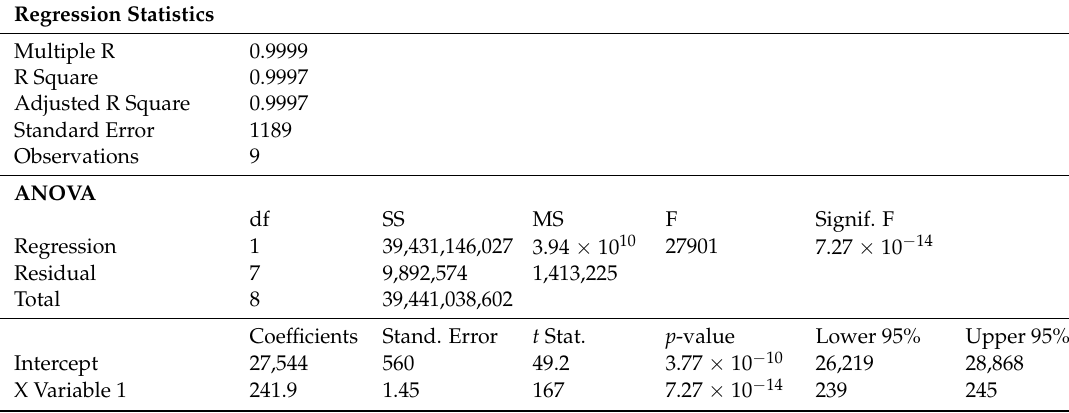
Table 1. Regression parameters of the calibration curve for 35 Cl (R—correlation coefficient; df—the degrees of freedom in the source; SS—the sum of squares due to the source; MS—the mean sum of squares due to the source; F—the